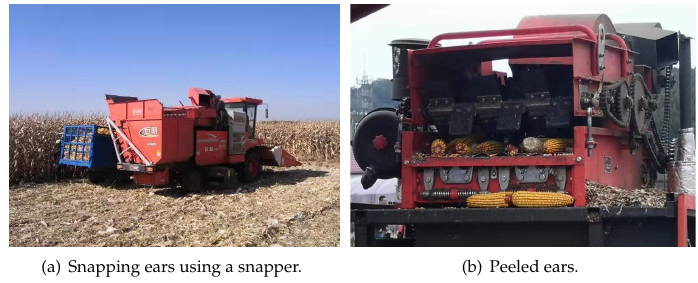
Figure 1. Actual scenes of corn ear harvest in China.